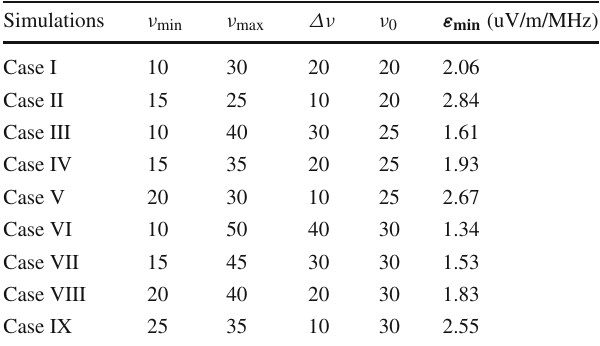
Table 1 Sensitivity parameters of radio UHECR and UHEC ν observa- tions, frequencies and bandwidths are in MHz